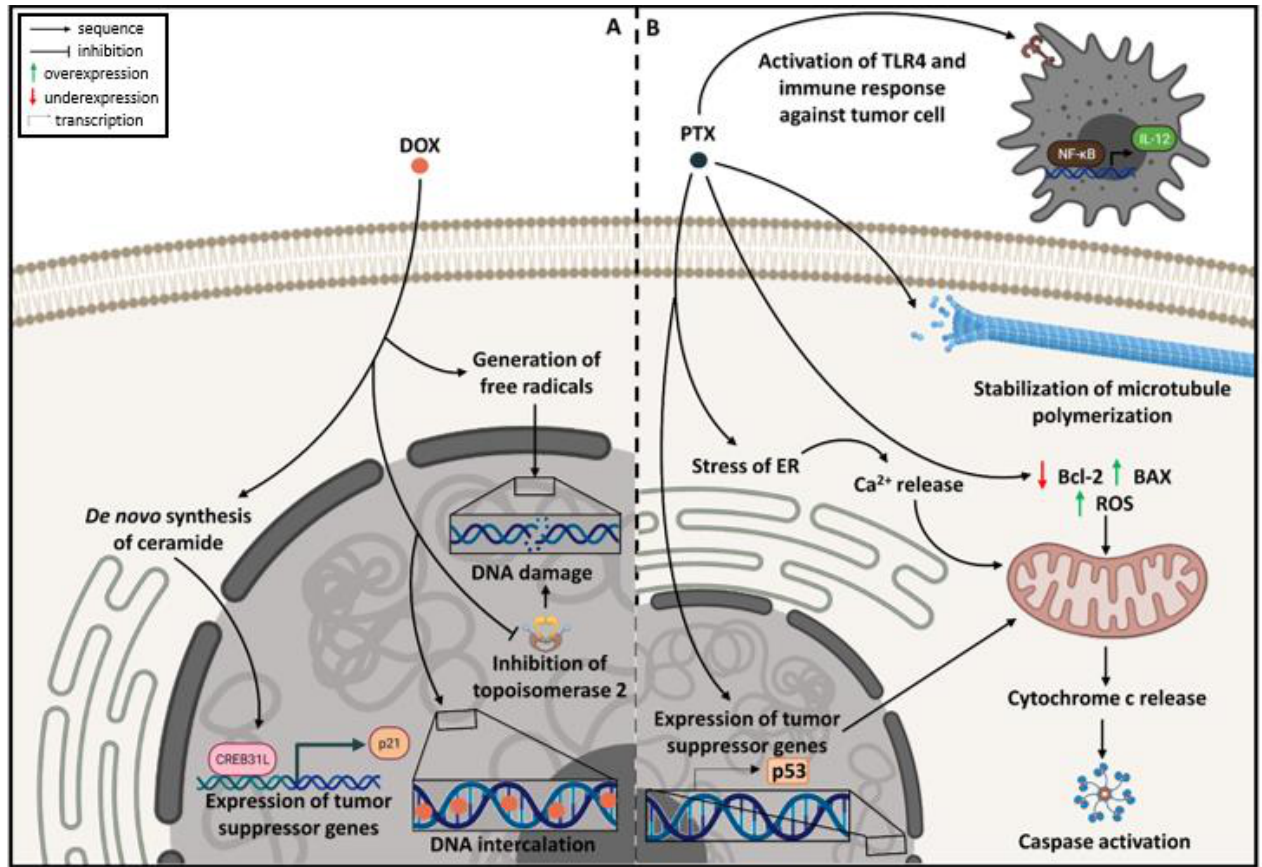
Figure 2. Mechanisms of action of doxorubicin — DOX ( A ) and paclitaxel — PTX ( B ); both drugs exert their effects by hampering tumor cell physiopathology. PTX also enhances patient’s immune response. (ER = endoplasmic reticulum; ROS = reactive oxygen species) (Created with BioRender.com).